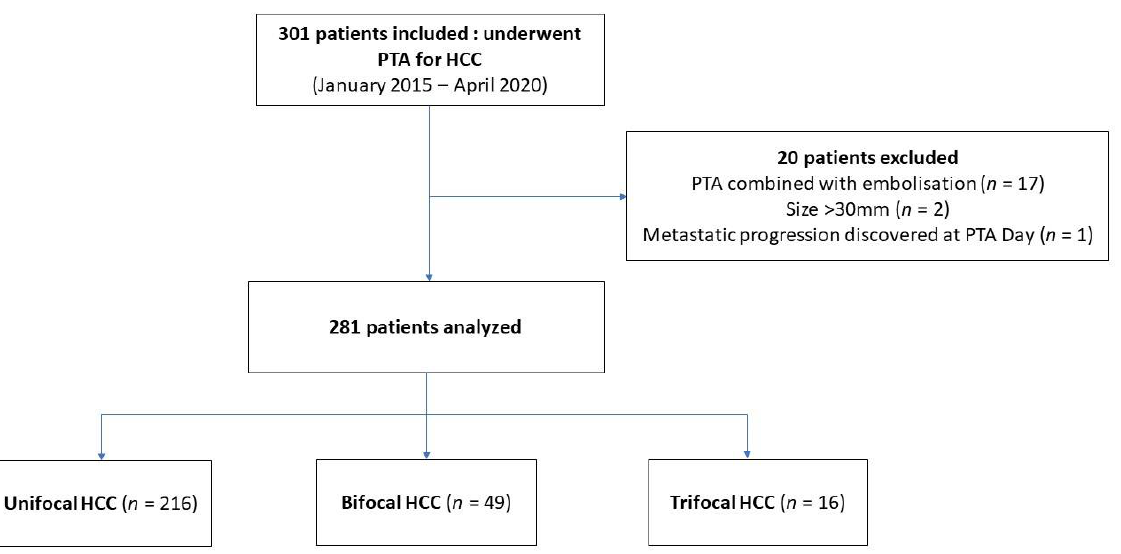
Figure 1. Figure 1. Flowchart.